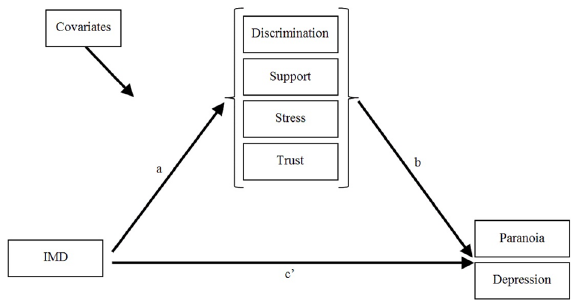
Figure 1. Illustration of the final model (model 3) used in the analysis. Please note that the mediators representing discrimination, support, stress and trust were allowed to covary. Covariates included age, sex, ethnicity and hallucinatory experiences. The mediating variables (discrimination, support, stress and trust) were regressed onto the IV - the index of multiple deprivation (IMD) variable (path a). The DVs (paranoia and depression) were regressed onto the mediating variables (path b) and the DVs were also regressed onto the IV IMD (path c 9 ) simultaneously. The effects from IMD to the mediating variables were linear regression estimates and the effects from the mediators to the symptoms were logistic estimates reported as odds